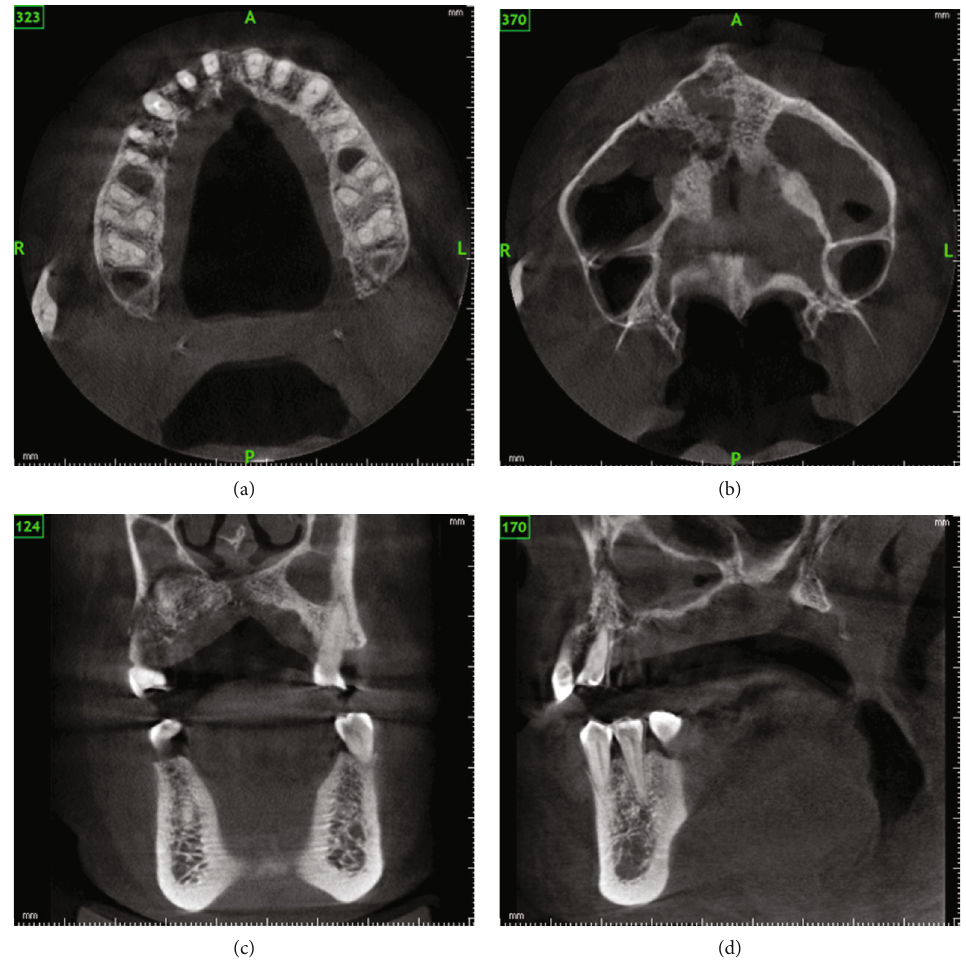
Figure 10: CBCT images of case 3 showing (a, b) axial views with osteolytic changes in the alveolus and palate with perforating sinus fl oor as seen in coronal views and sagittal views (c,